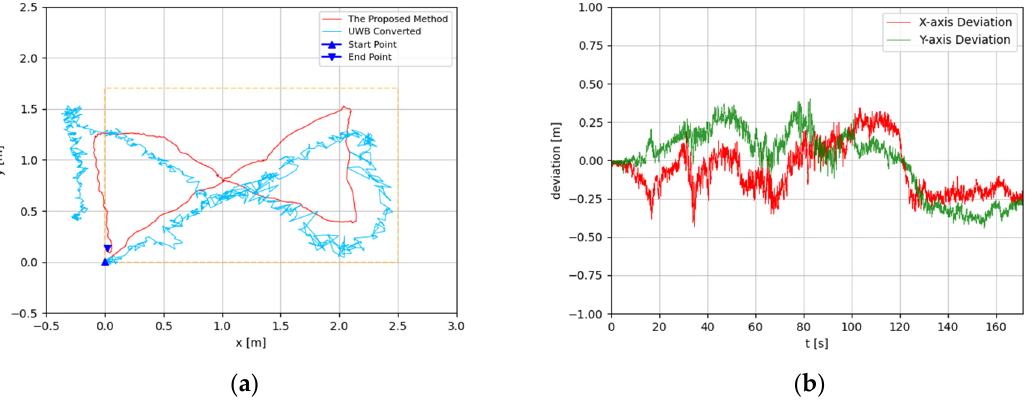
Figure 14. ( a ) Trajectory of ‘X’-shaped path in the first test; ( b ) Positioning comparison of ‘X’-shaped path in the first test.